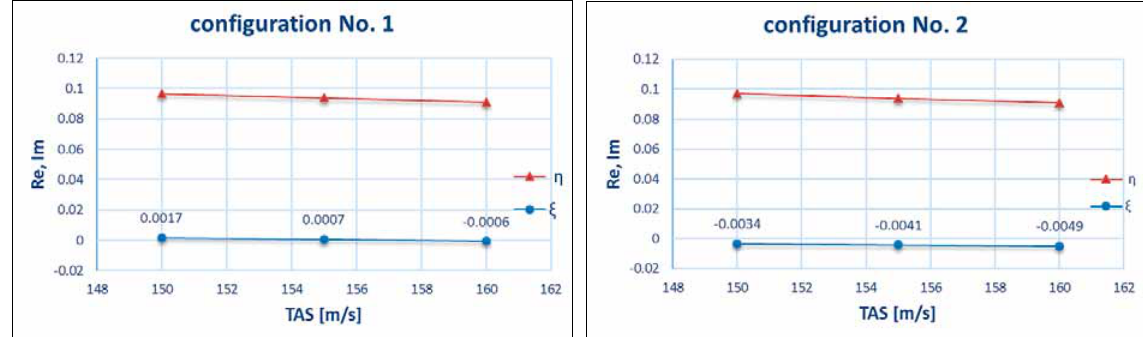
Fig. 10. Eigenvalues of the real and imaginary part for the phugoid